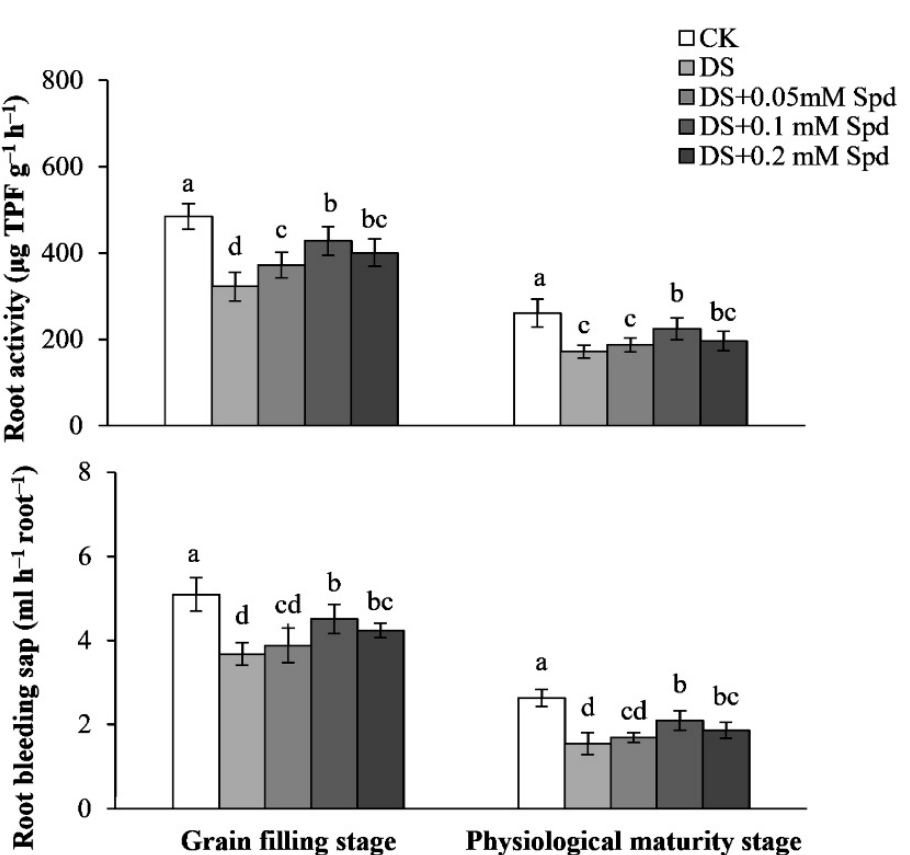
Figure 3. Effects of exogenous spermidine on root bleeding sap rate of maize under drought stress. Different letters within the same column indicate significant difference at 5% level.